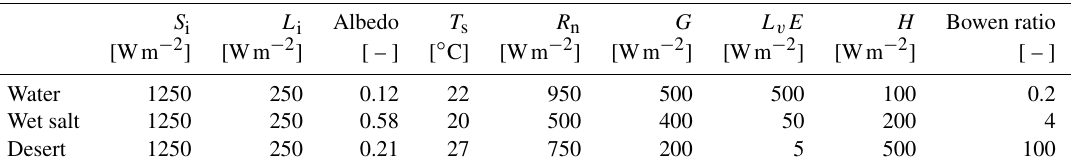
Table 2. Radiation and surface energy balance variables measured and inferred from complementary measurements above water, wet-salt and desert surfaces during the E-DATA experiment. Maximum mean values of incoming shortwave ( S i ) and longwave ( L i ) radiation, albedo, surface temperature ( T s ), R n , G , L v E , H , and daily mean of Bowen